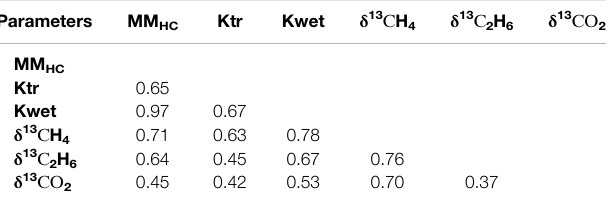
TABLE 5 | Correlation (r 2 ) between gas genetic indicators of the study